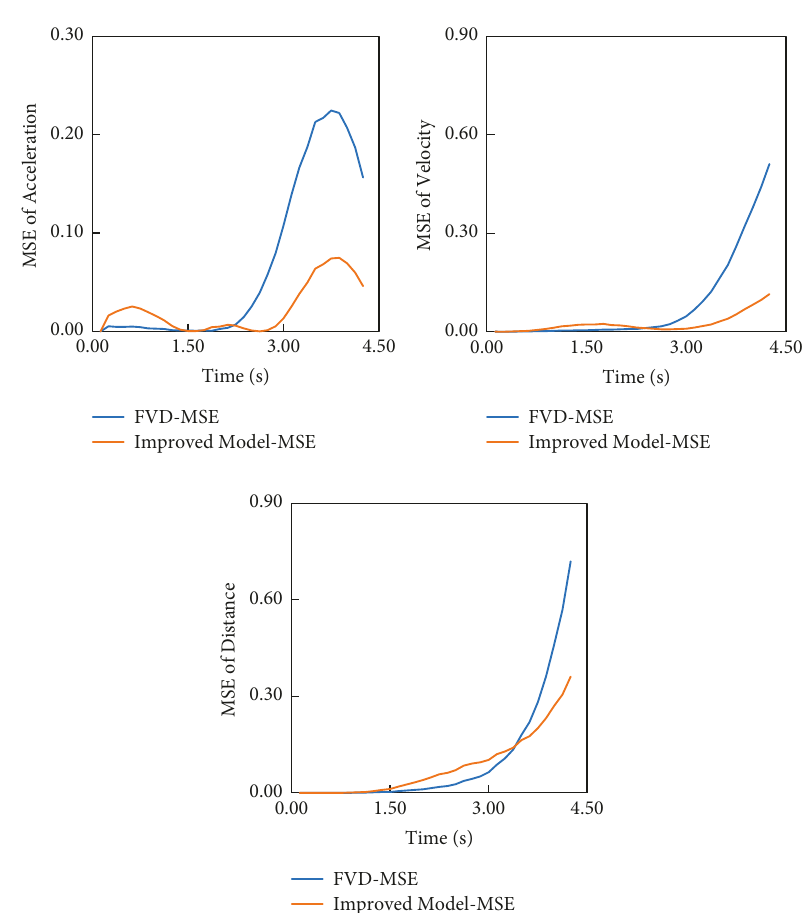
Figure 13: The curves of a subject vehicle’s acceleration, speed, and distance in a bus-bus